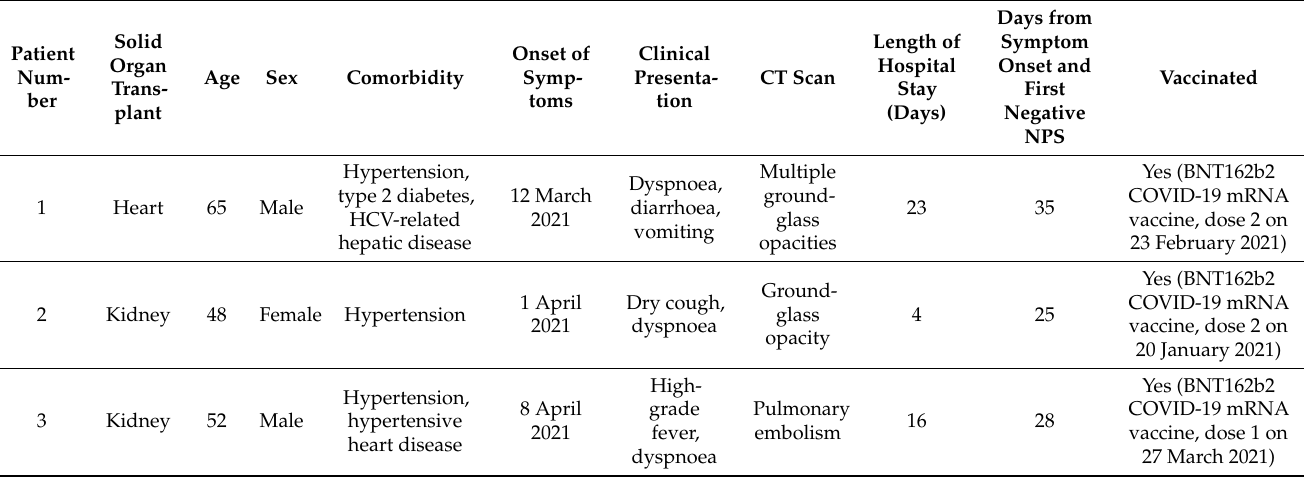
Table 1. Demographic and clinical characteristics of the three solid-organ transplant recipients with COVID-19. Solid Patient Organ Num- Trans- ber